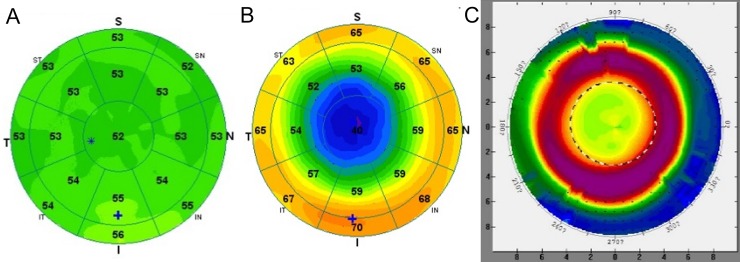
Representative corneal epithelial thickness and topography during orthokeratology.The corneal epithelial thickness maps are divided into a total of 17 sectors: a central 2 mm diameter zone, eight paracentral zones within an annulus between the 2 and 5 mm diameter rings, and eight mid-peripheral zones within an annulus between the 5 and 6 mm diameter rings. The epithelial thickness map shows central compression area surrounded by annular mid-peripheral thickening area and they seem to fit to tangential topographic images. (A) Baseline epithelial thickness, (B) post-OK epithelial thickness map and (C) post-OK tangential topography.